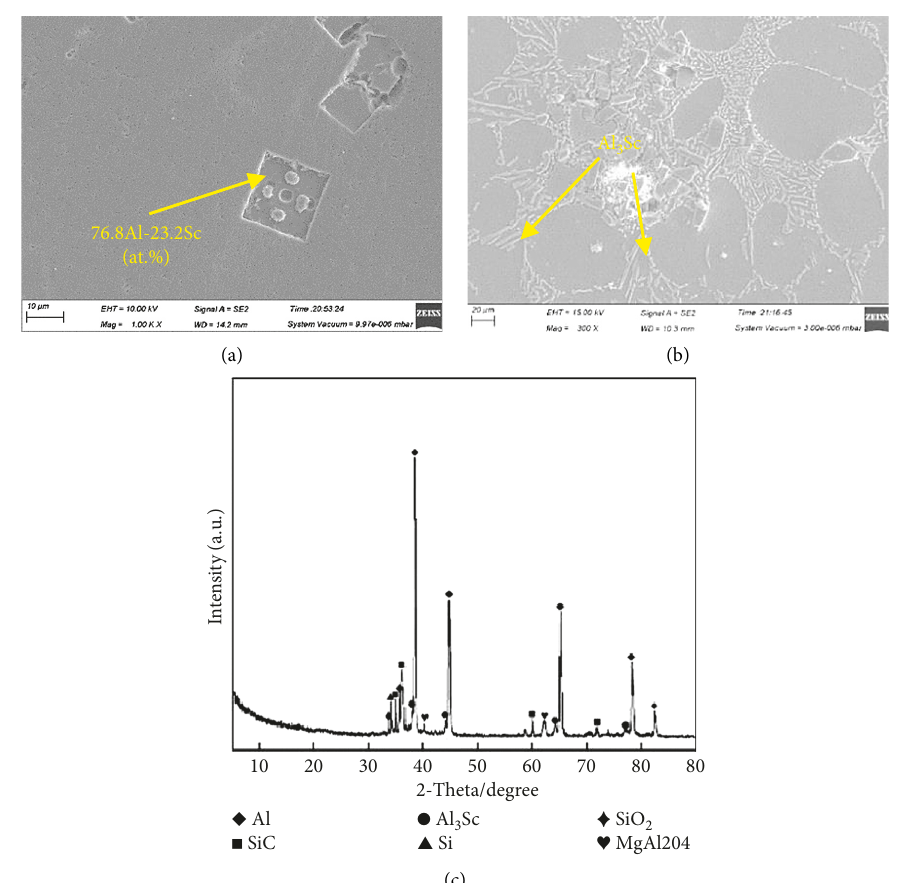
Figure 7: SEM images and EDS result (a) of Al 3 Sc, microstructures after addition of Sc (b), and X-ray diffraction of 10%SiC p /Al+0.4Sc